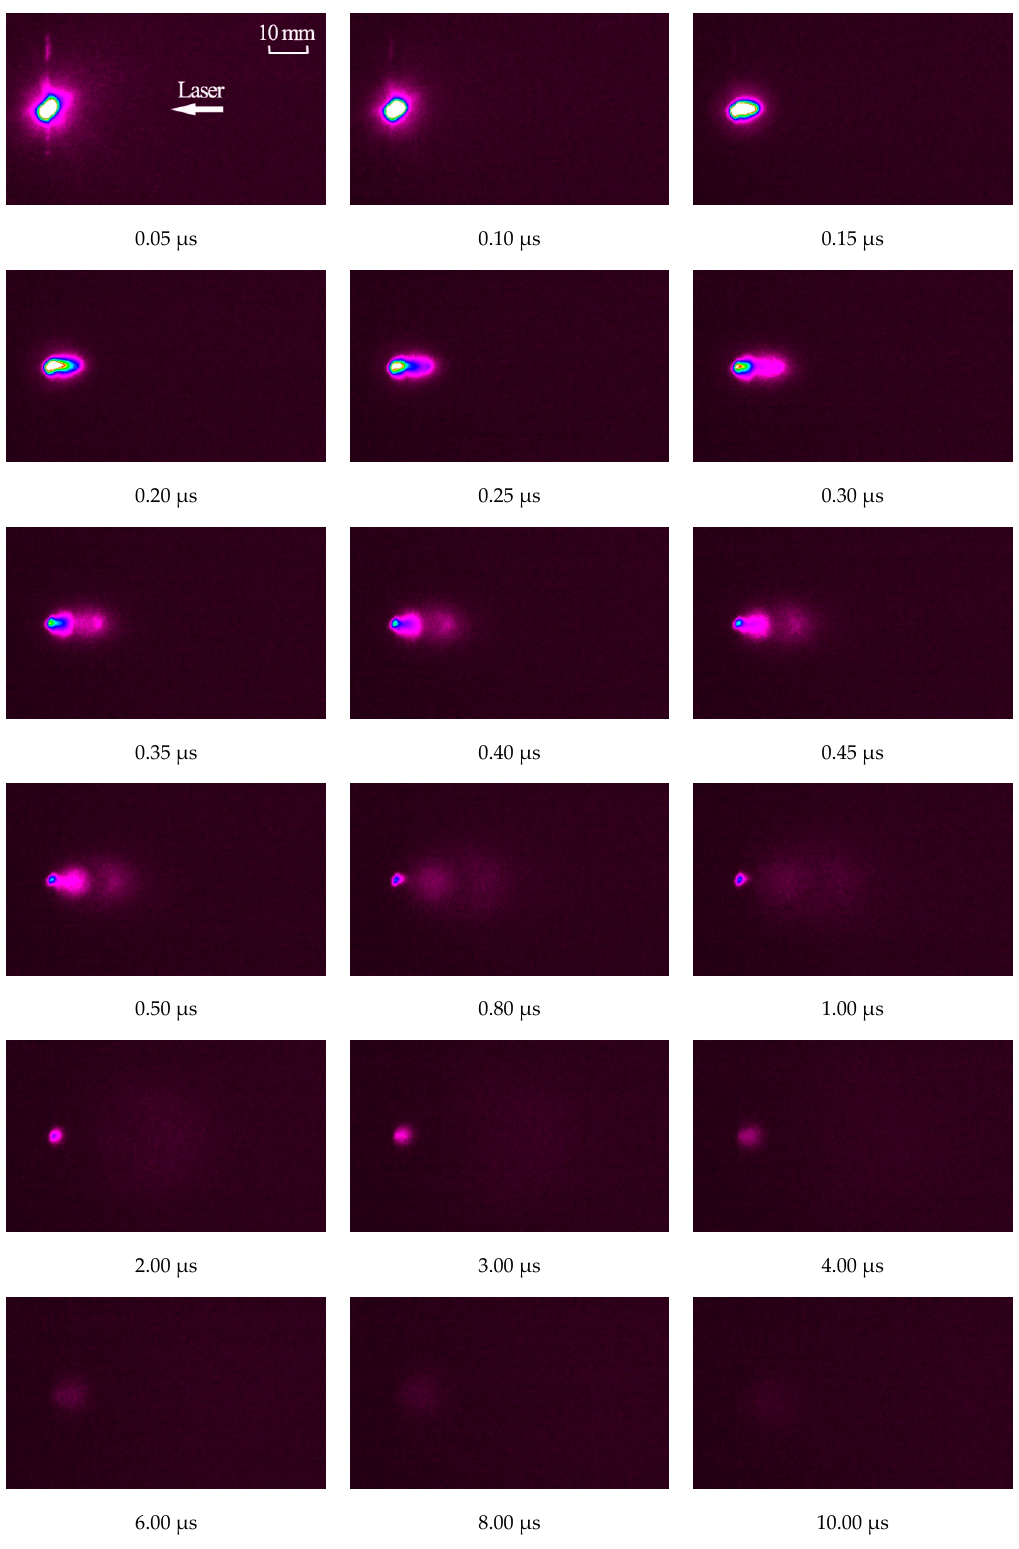
Figure 19. The plasma plume evolution process of 26.5% Al at ambient pressure 5 Pa and laser energy 542.3 mJ.